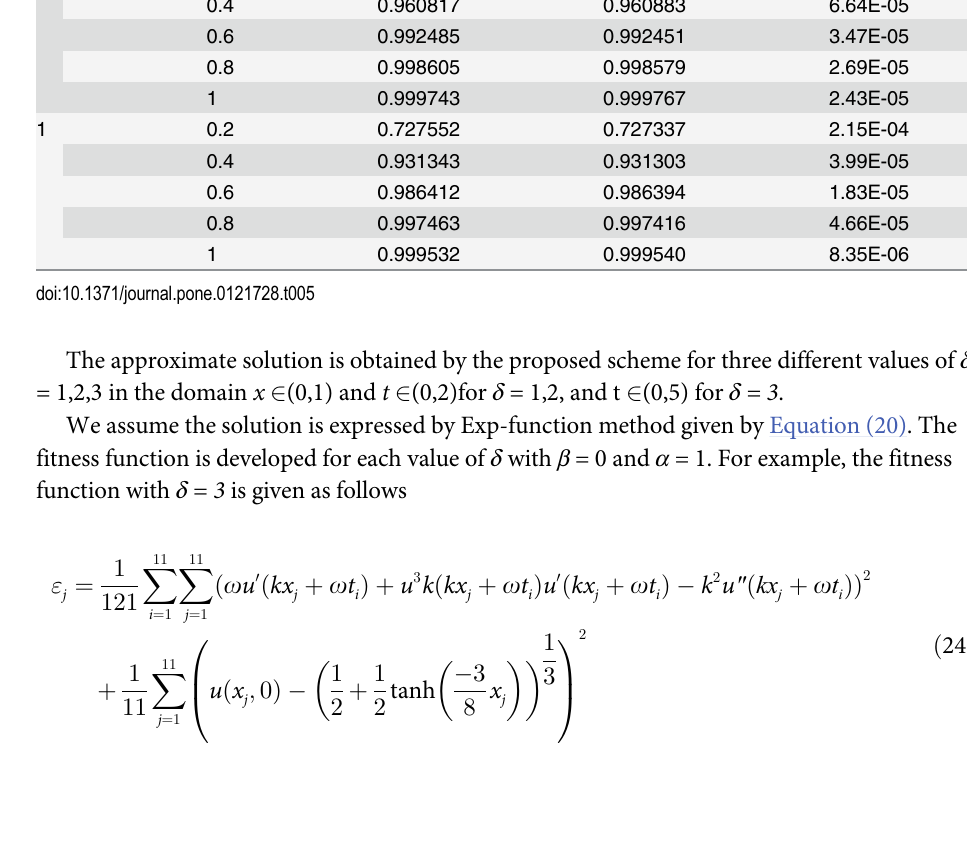
_ ( η ) Absolute errors exact u